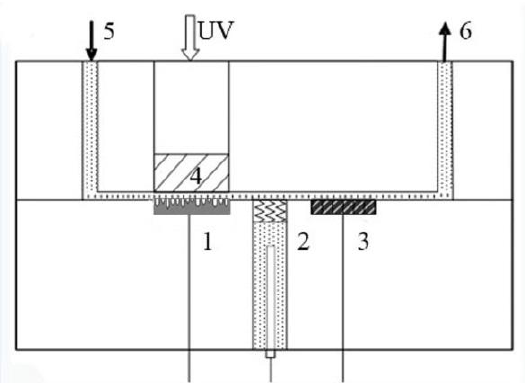
Figure 1. Schematic depiction of the thin layer reactor based on a WO nanopores sensor; (2) saturated Ag/AgCl reference electrode; (3) Pt counter electrode; (4) quartz window; (5) flow inlet; (6) flow